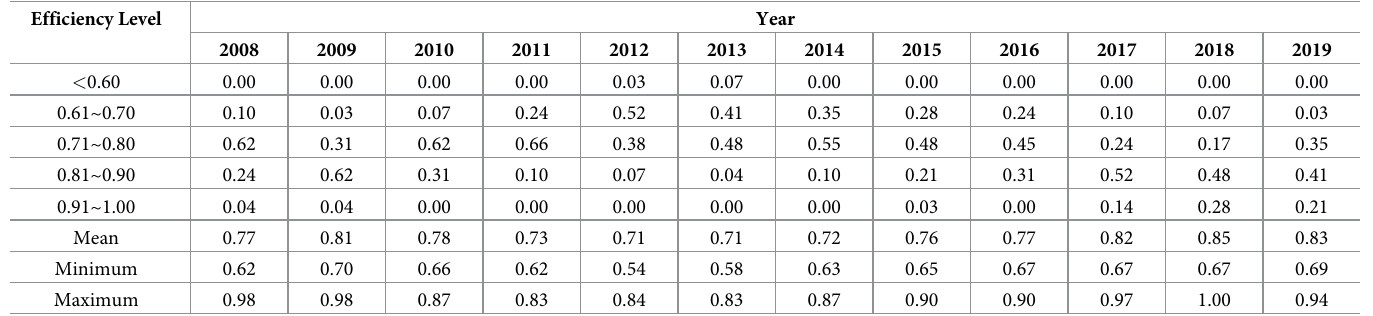
Table 7. Frequency distribution of cost efficiency estimates for fattening pigs, 2008–19. Efficiency